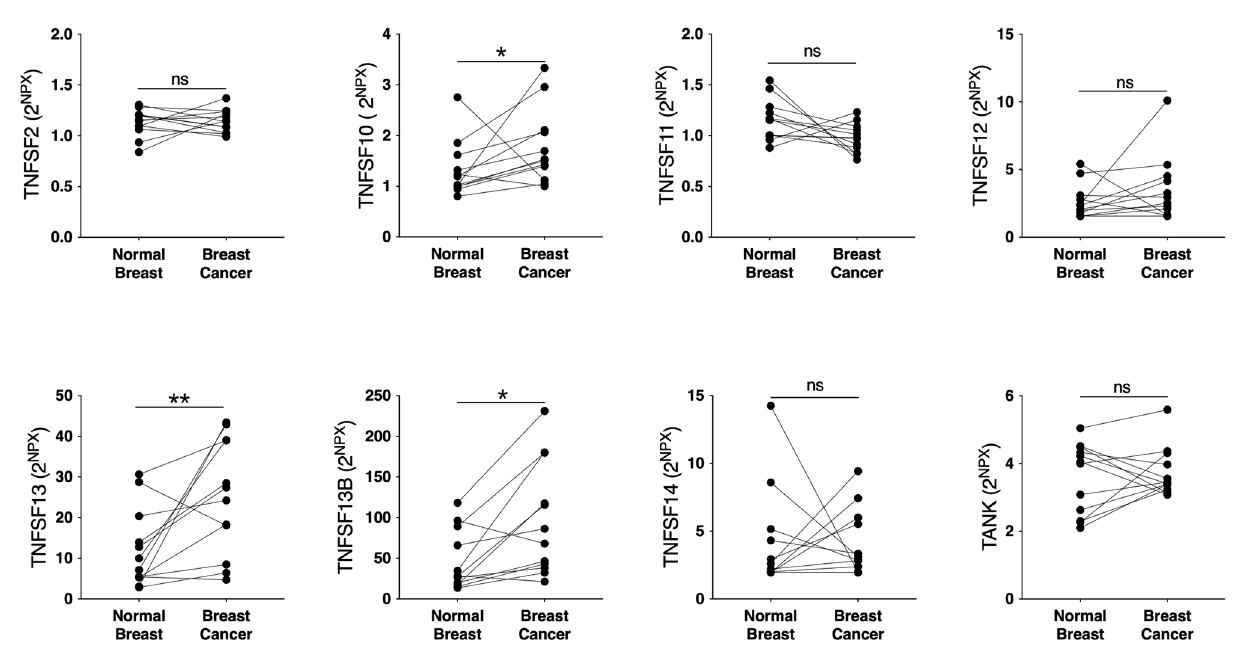
FIGURE 1 | Extracellular levels of TNFSF in vivo in breast cancers and adjacent normal breast tissue. 12 patients with estrogen receptor positive breast cancer underwent microdialysis before surgery. One catheter was inserted into the breast cancer and another into adjacent normal breast tissue. Proteins were quanti fi ed using proximity extension assay. Data represents protein abundance in linear values (2 NPX as described in the materials and methods section). * P < 0.05, ** P < 0.01, ns, not signi fi